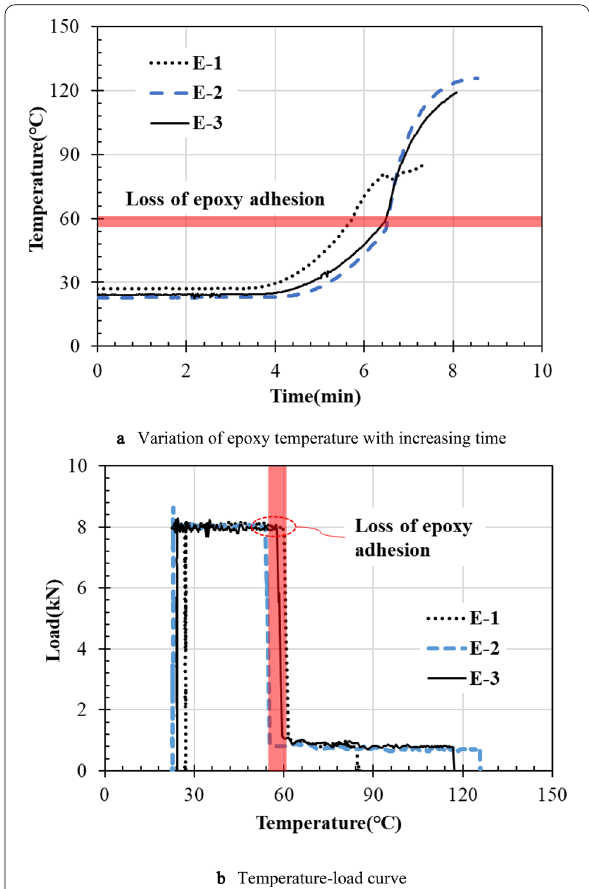
Fig. 6 Adhesion variation of epoxy during temperature increasing.